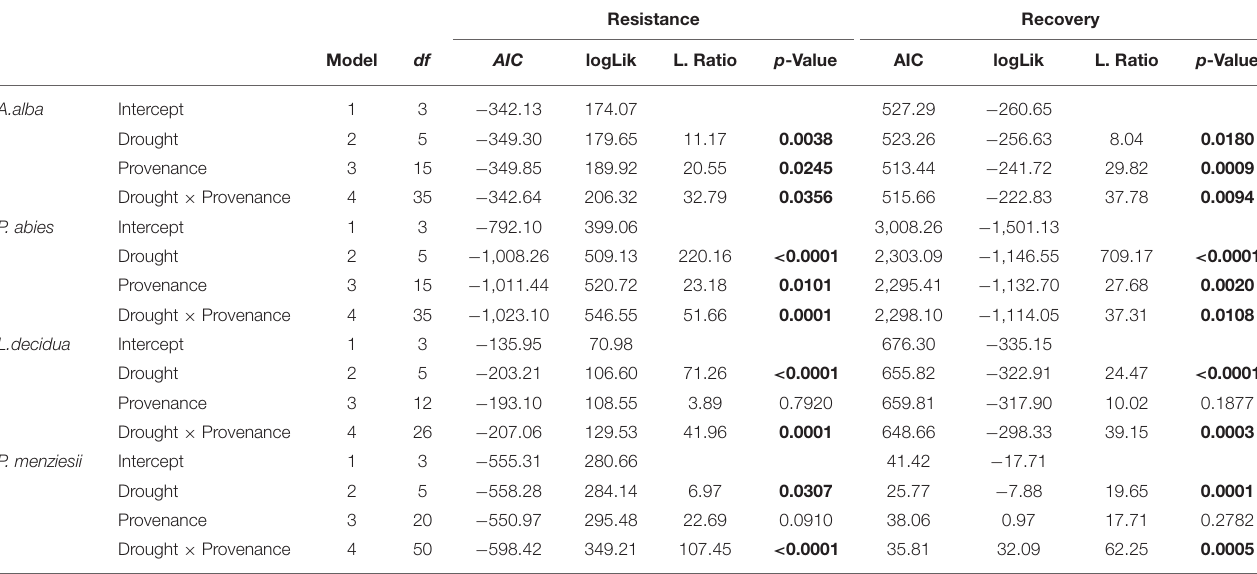
TABLE 3 | Variation among provenances and drought years for individual species as revealed by repeated measure